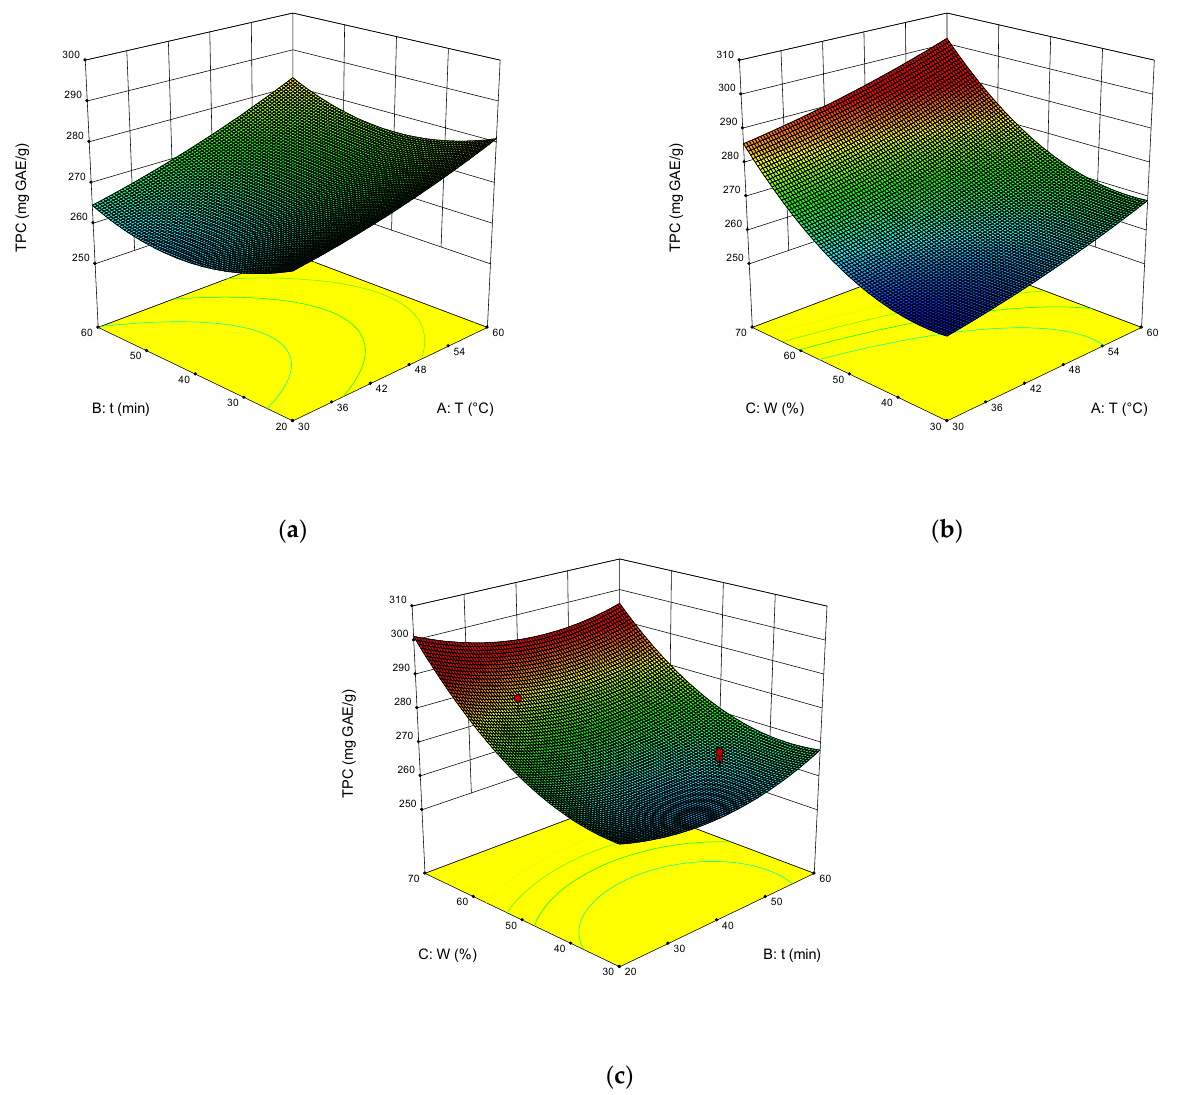
Figure 4. Response contour plots ( a – c ) showing the extraction temperature (A), extraction time (B), and water content (C) effect on the extraction yield of TPC.